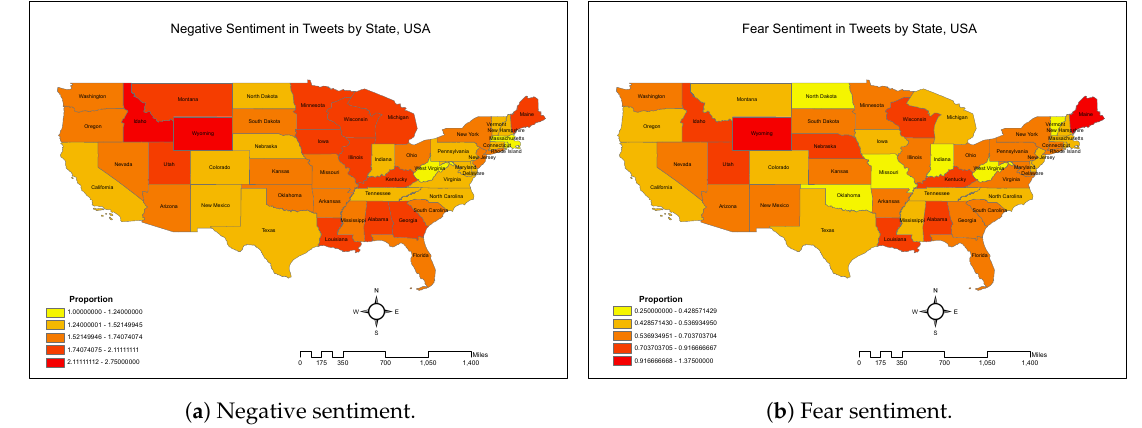
Figure 3. Sentiment